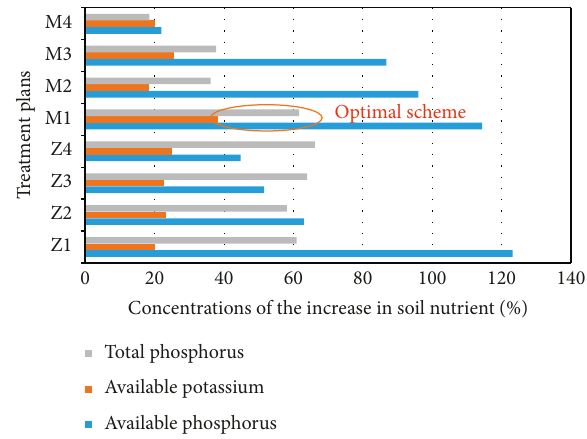
Figure 8: Fertility level of different treatment plans for compost improvement.